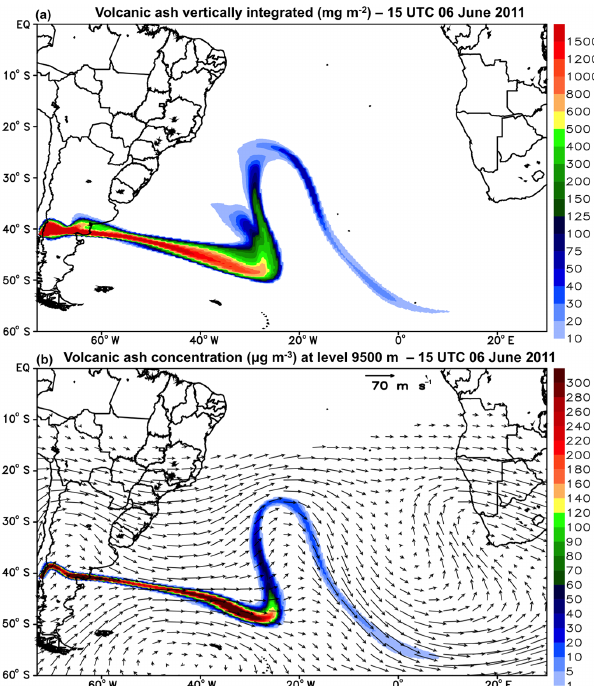
Figure 17. (a) Vertically integrated total mass of ash (mgm − 2 ) . (b) Total ash mass concentration (µgm − 3 ) at the level of approx- imately 9500m above the surface and the associated horizontal wind. Both panels show results for 6 June 2011 at 15:00UTC as simulated by the BRAMS